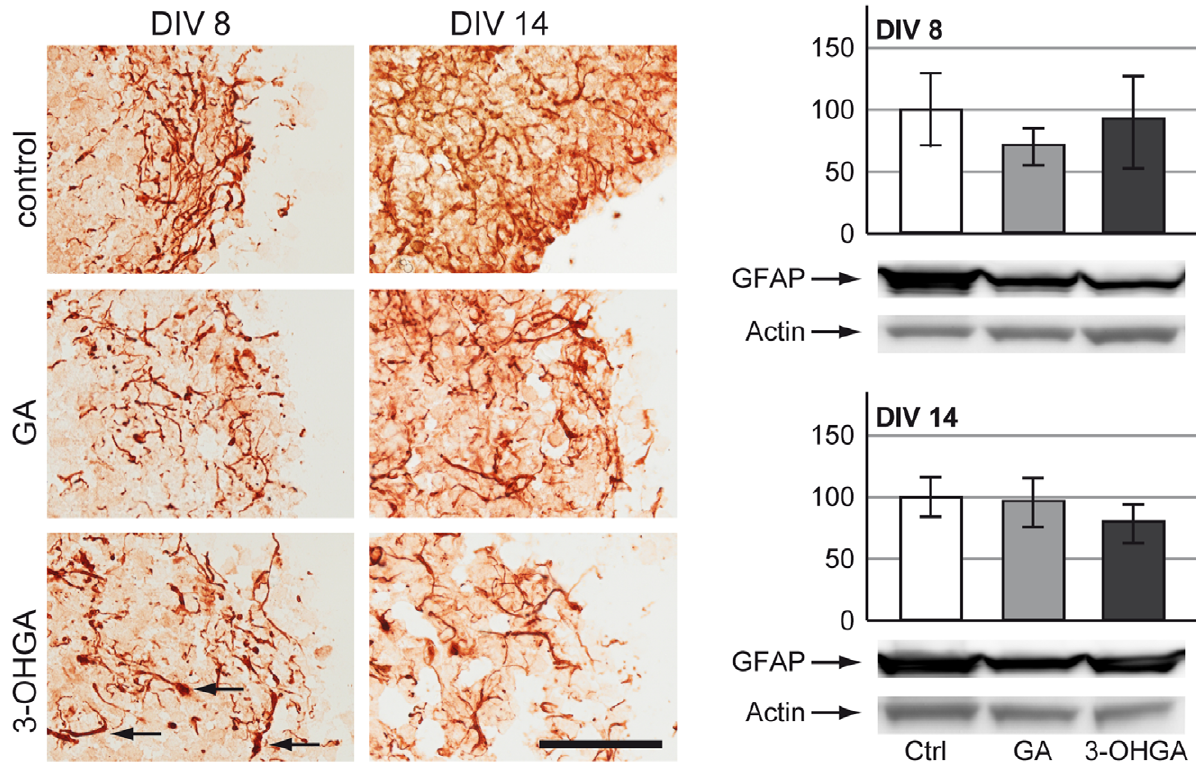
Figure 3. Effects of GA and 3-OHGA on astrocytes. (Left panel) Immunohistochemical staining for glial fibrillary acidic protein (GFAP) on cryosections of cultures derived from protocol A (DIV 8) and protocol B (DIV 14). Swollen proximal fibers are indicated by black arrows. Scale bar: 100 m m. (Right panel) Representative western blots with data quantification of whole-cell lysates for GFAP for protocol A (DIV 8, above) and protocol B (DIV 14, below). Actin was used as a loading control. The quantifications of GFAP levels are expressed as percentage of respective controls. The values represent the mean 6 SD from 3 replicates taken from 2 independent experiments.